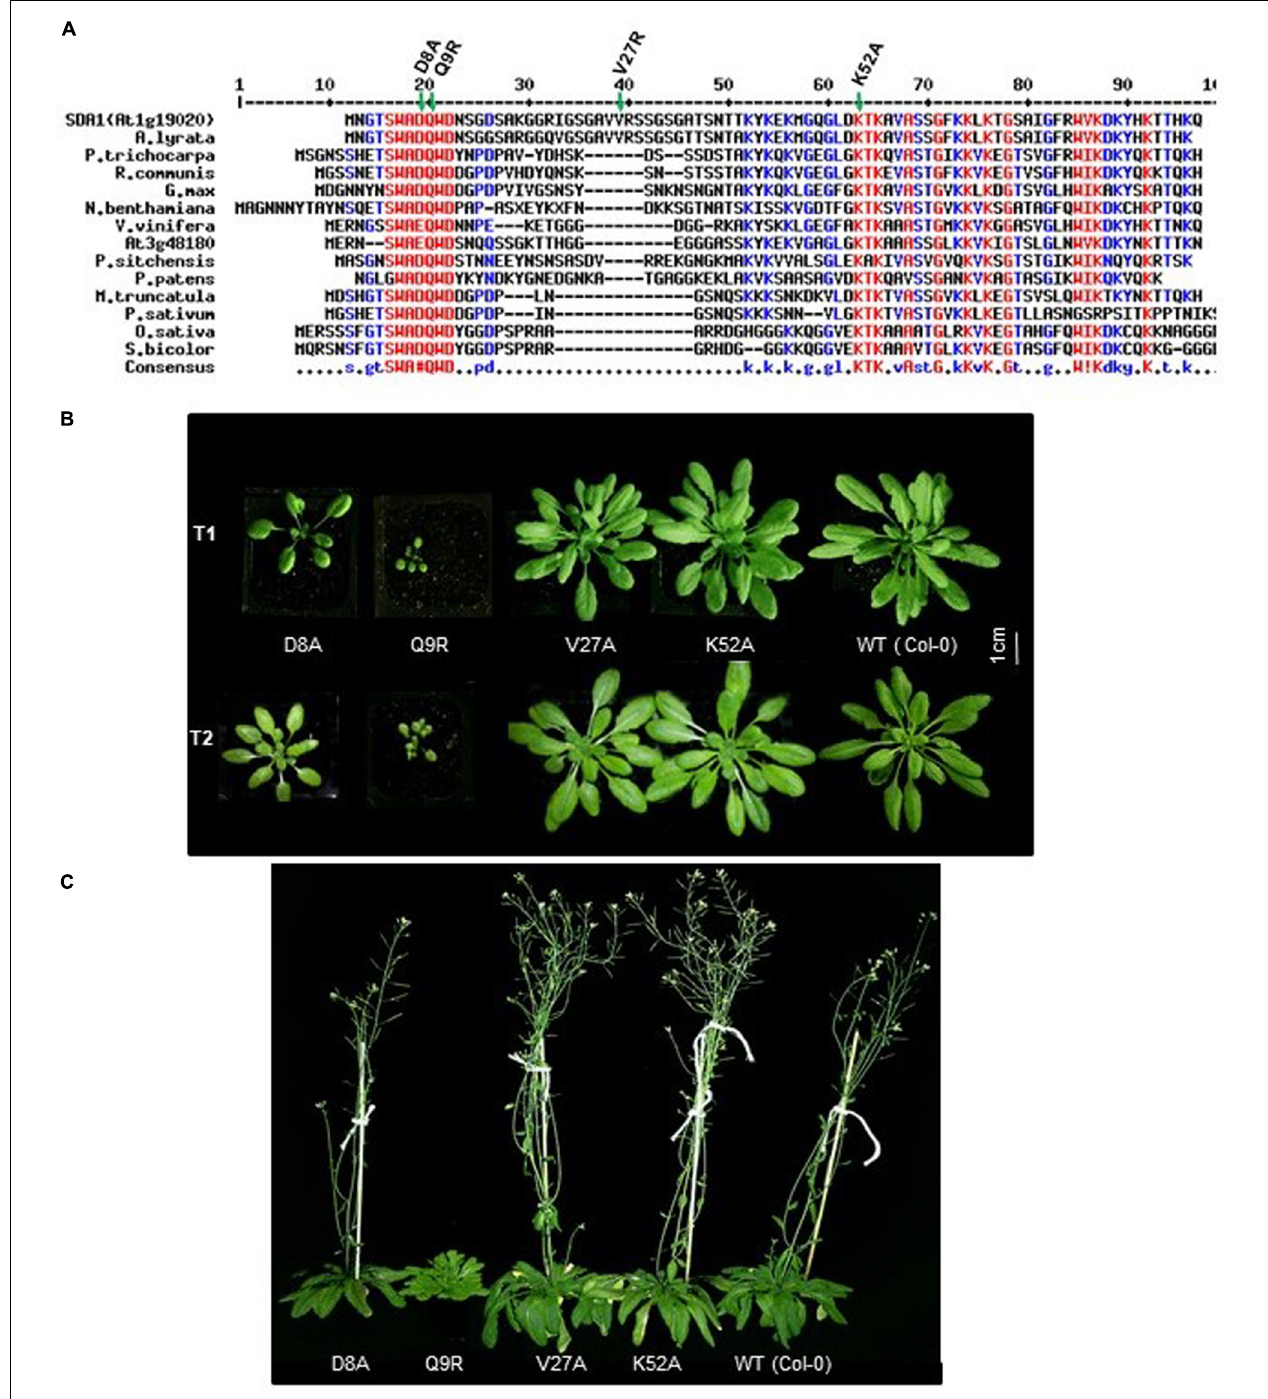
FIGURE 6 | Conserved D8 and Q9 amino acid of SDA1 are functionally important for proper growth. (A) Alignment of Small Defense-Associated (SDA) protein family members in plants. An Alignment was done using MultAlin. Conserved (S/G)WA(D/E)QWD domain is underlined. All engineered amino acid mutants are indicated by asterisks. Arabidopsis lyrate (related to Arabidopsis), Populus trichocarpa (black cottonwood), Ricinus communis (castor bean), Glycine max (soybean), Nicotiana benthamiana (related to tobacco), Vitis vinifera (common grape vine), Picea sitchensis (sitka spruce), Physcomitrella patens (spreading earthmoss), Medicago truncatula (barrelclover), Pisum sativum (pea), Oryza sativa (asian rice), Sorghum bicolor (sorghum). (B) Growth of T 1 and T 2 generation of SDA1 D8A, Q9R, V27A, K52A mutant and WT (wild type) Col-0 plants. Plants were photographed at 25 days after sowing in day neutral light (12 h light:12 h dark). (C) Flowering of SDA1 D8A, Q9R, V27A, K52A mutant and WT Col-0 plants. Plants are photographed at 70 days after sowing (DAS) in day neutral light (12 h light: 12 h dark).